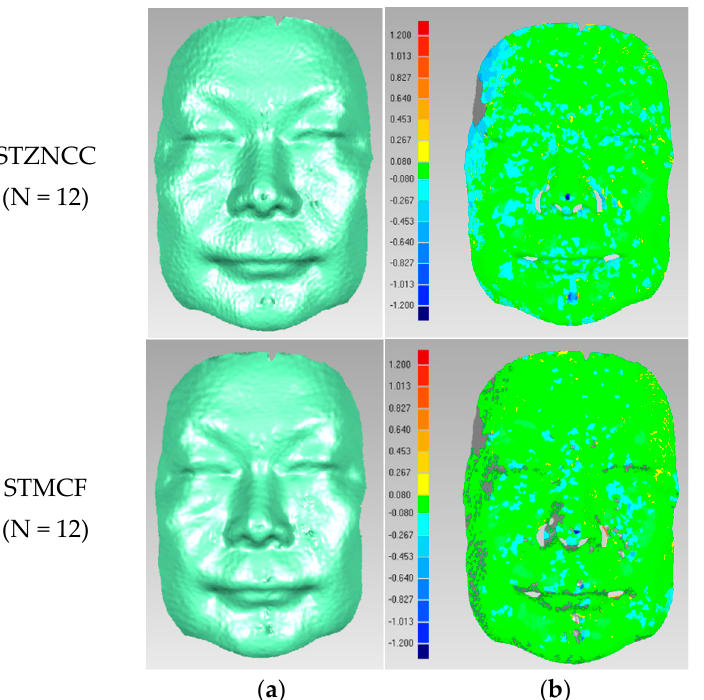
Figure 11. ( a ) 3D reconstruction result of the plastic human face (N = 12); ( b ) Corresponding error distribution map.